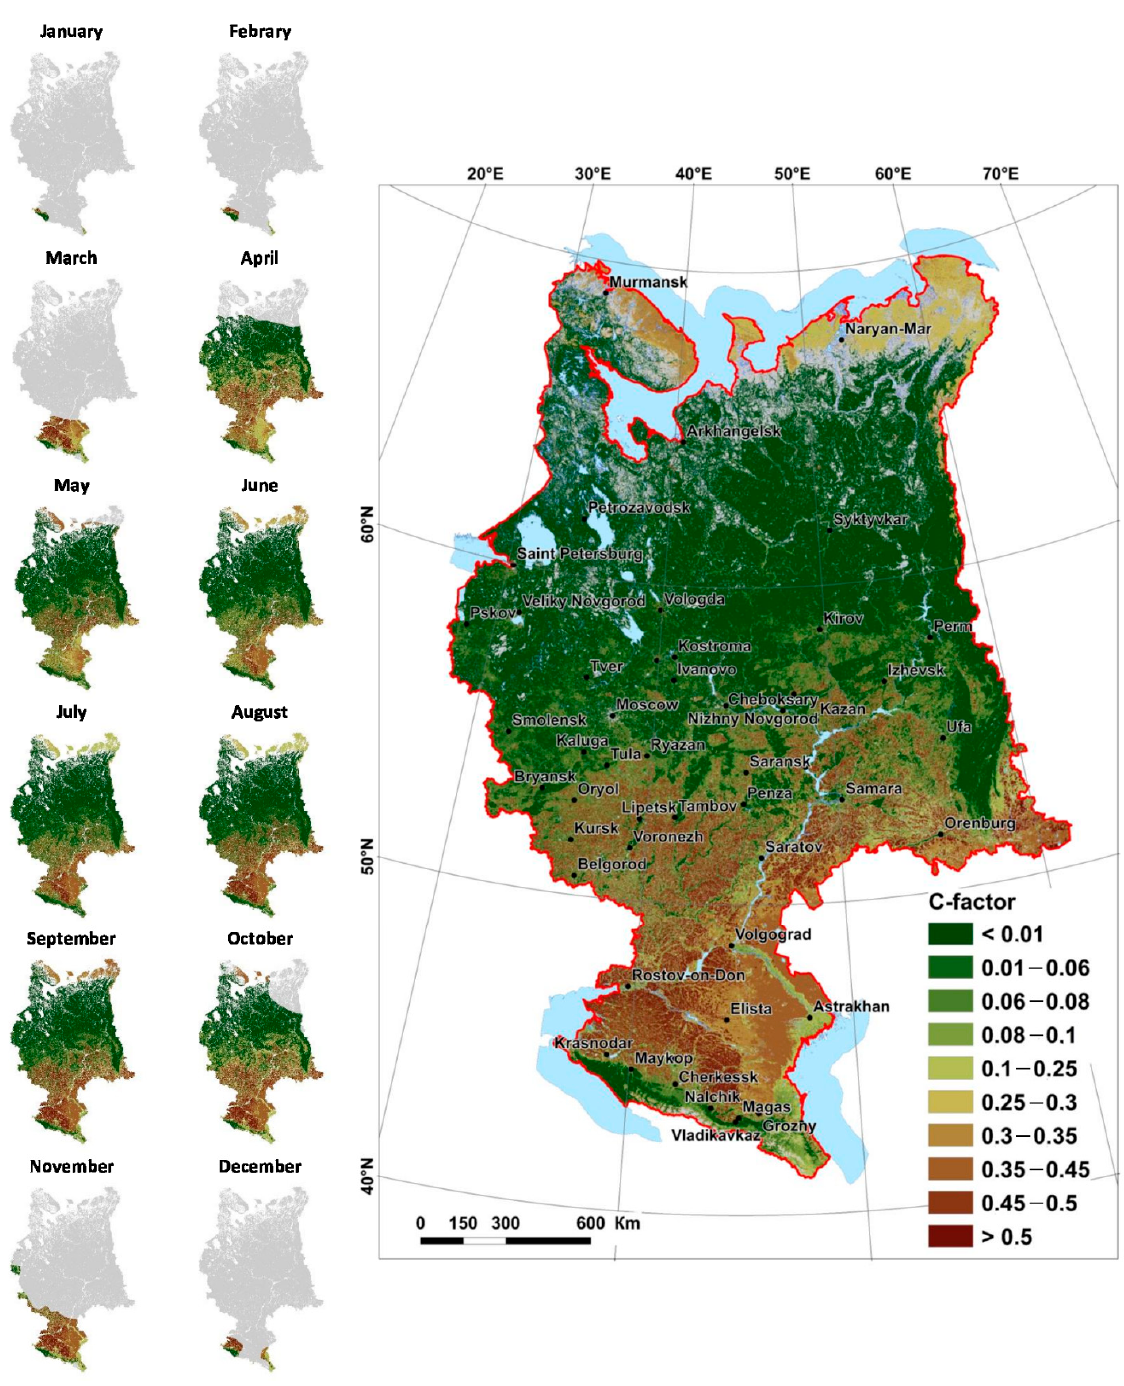
Figure 4. Spatial distribution of the C-factor in the European Russia, monthly and annual estimates (average long-term 2014-2019).